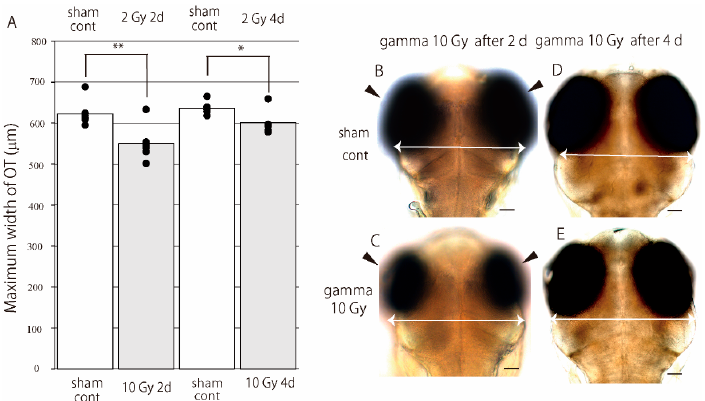
Figure 6. Gamma-ray irradiation on the embryos at late embryogenesis period resulted in the incomplete development of brain. Medaka embryos at 3 dpf were irradiated with 10 Gy gamma-rays and maximum width of OT were measured at 2 and 4 days after the irradiation ( A ). Each independent data was shown with black circled marker in A. At 2 days after the irradiation, the maximum width of OT of the irradiated embryos ( C ) were smaller than the non-irradiated sham controls ( B ) with a statistical significance. At 4 days after the irradiation, OT of the irradiated embryos ( E ) were still smaller than the non-irradiated sham controls ( D ) with a statistical significance. Retina of the irradiated embryos were also smaller than the sham controls at 2 days after the irradiation (arrowheads in B and C ). All of the irradiated embryos hatched normally. A p * value < 0.05 was considered statistically significant and p ** < 0.01 was considered highly statistically significant. Scale bar = 50 µ